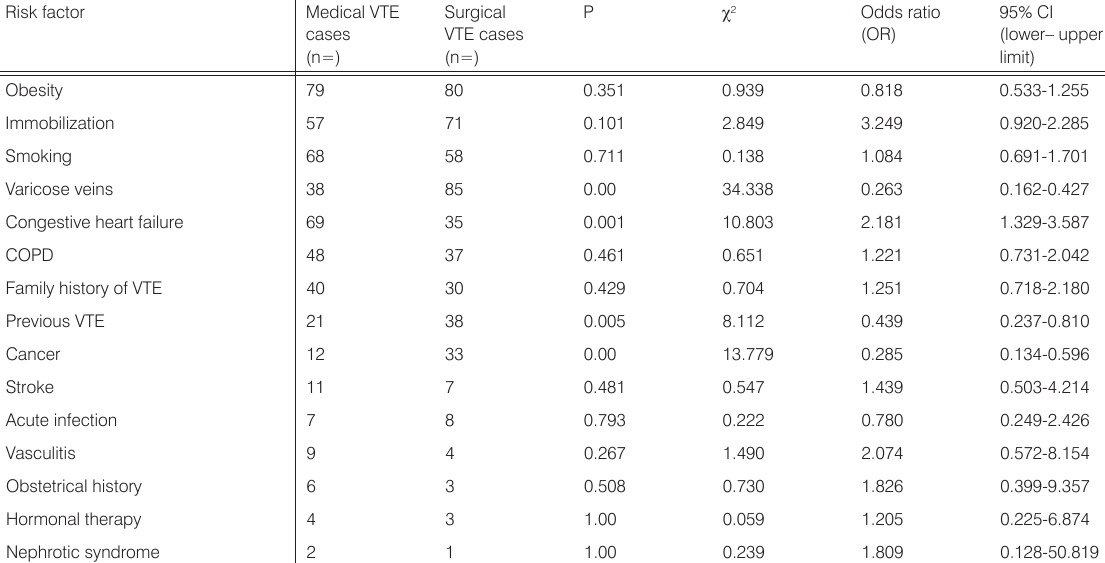
Table 3. The distribution of the risk factors in medical versus surgical patients Risk